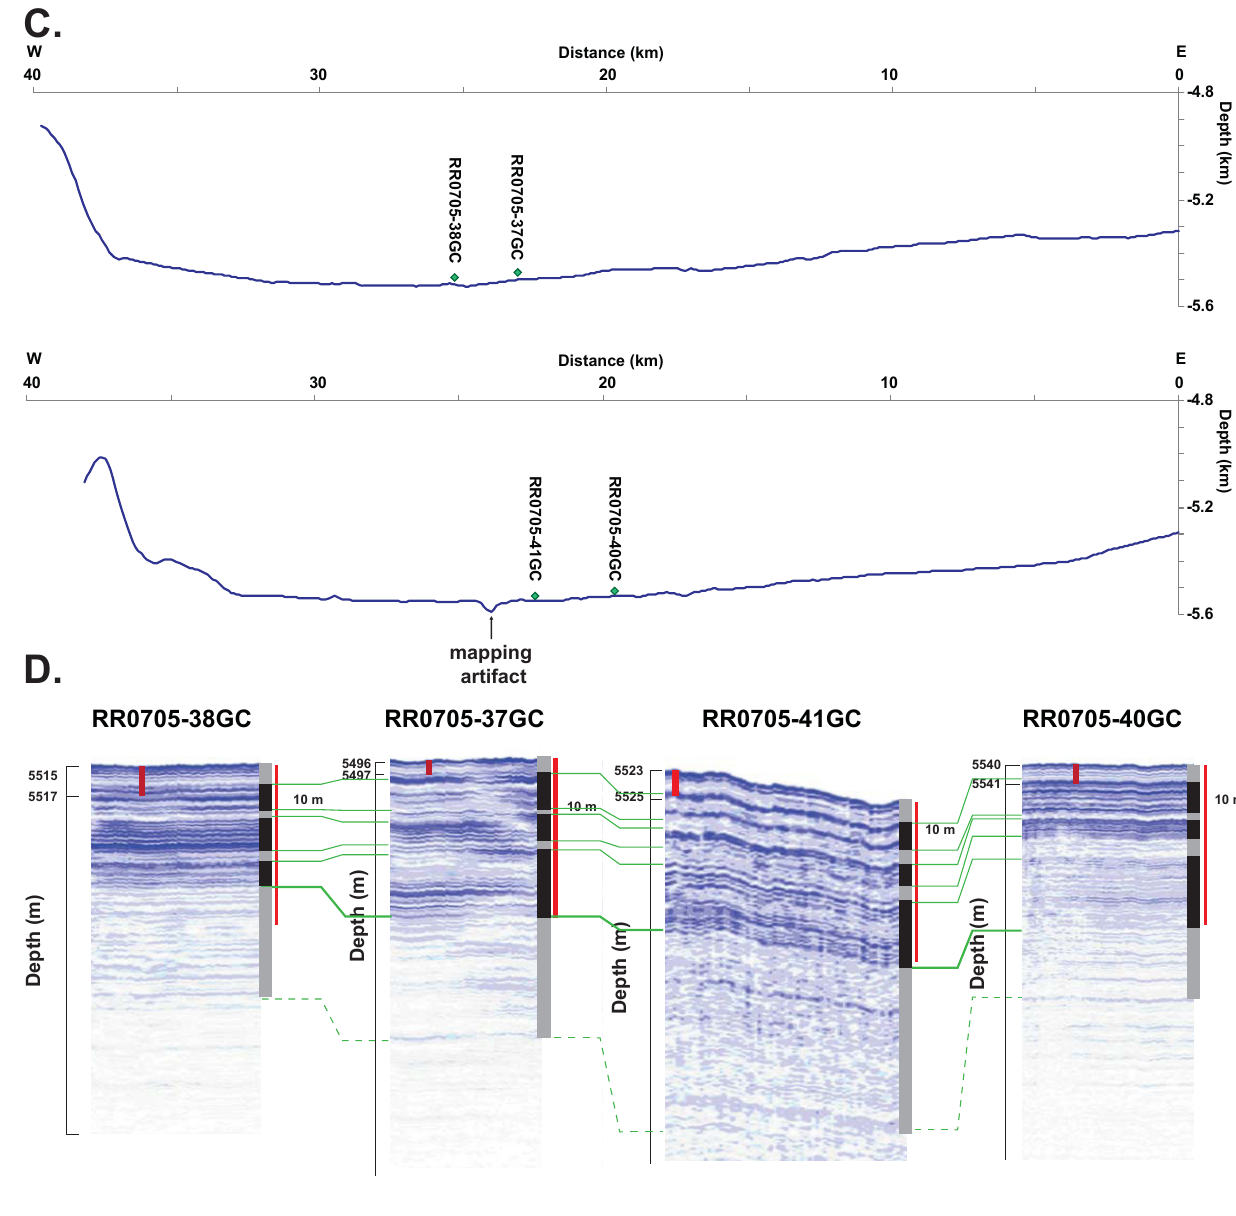
Fig. 10. (C) Elevation is plotted versus distance along a strike line aligned to core pairs. Core locations are labeled in green. Profile locations are plotted as red lines in (B, D) 3.5kHz CHIRP seismic data collected at core sites are processed in SioSeis and plotted in SeiSee (seismic envelope). Core locations are designated by a red line scaled to core length. Horizontal extent of seismic data are unresolvable at the scale in (A) . Seismic data for cores 37GC, 38GC, and 40GC were collected while the ship maintained position over the core location. Seismic data for core 41GC were collected while leaving the core site, so the horizontal scale is